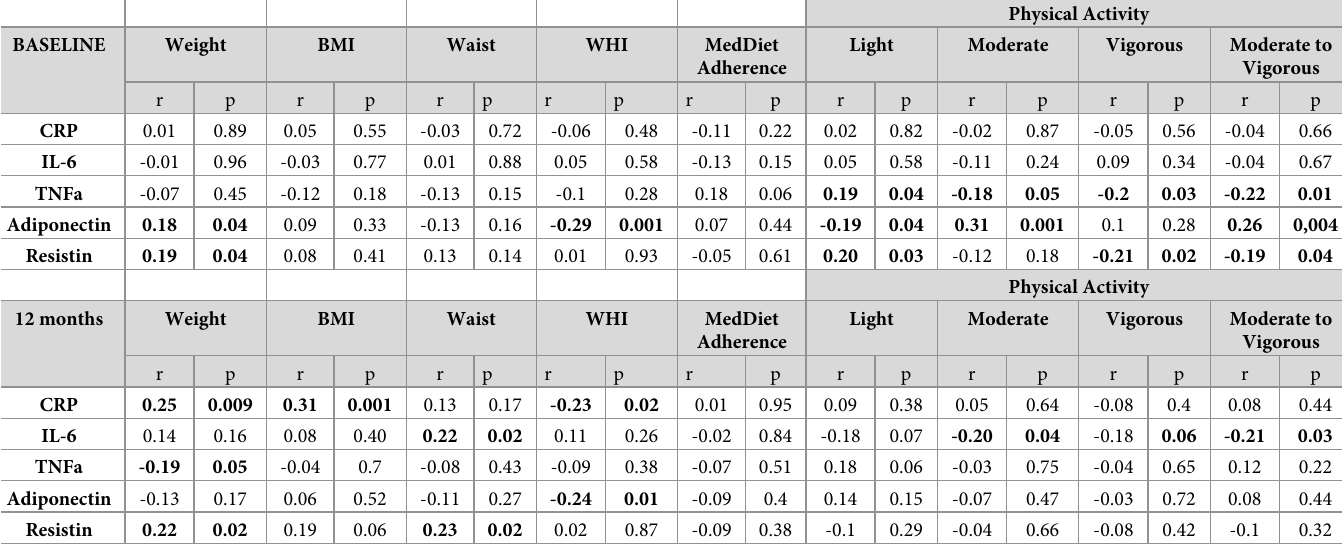
Table 4. Pearson correlation coefficient: Inflammatory biomarkers and adipokines vs. anthropometric parameters, Mediterranean diet adherence, and physical activity intensity levels at baseline and after 12 months of intervention.